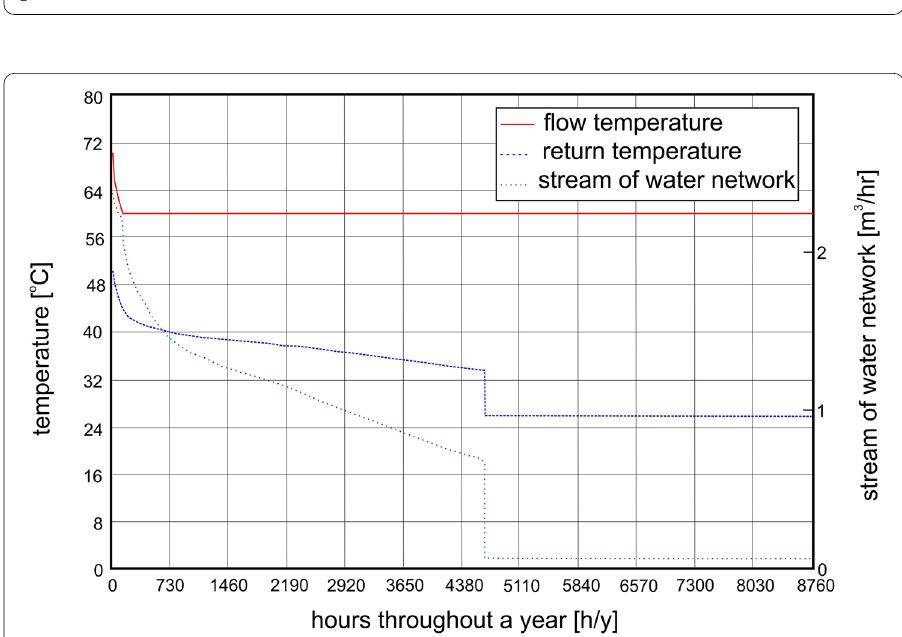
Fig. 10 Structured demand curve for supply temperature and heating medium flow rate as well as return temperature for the large